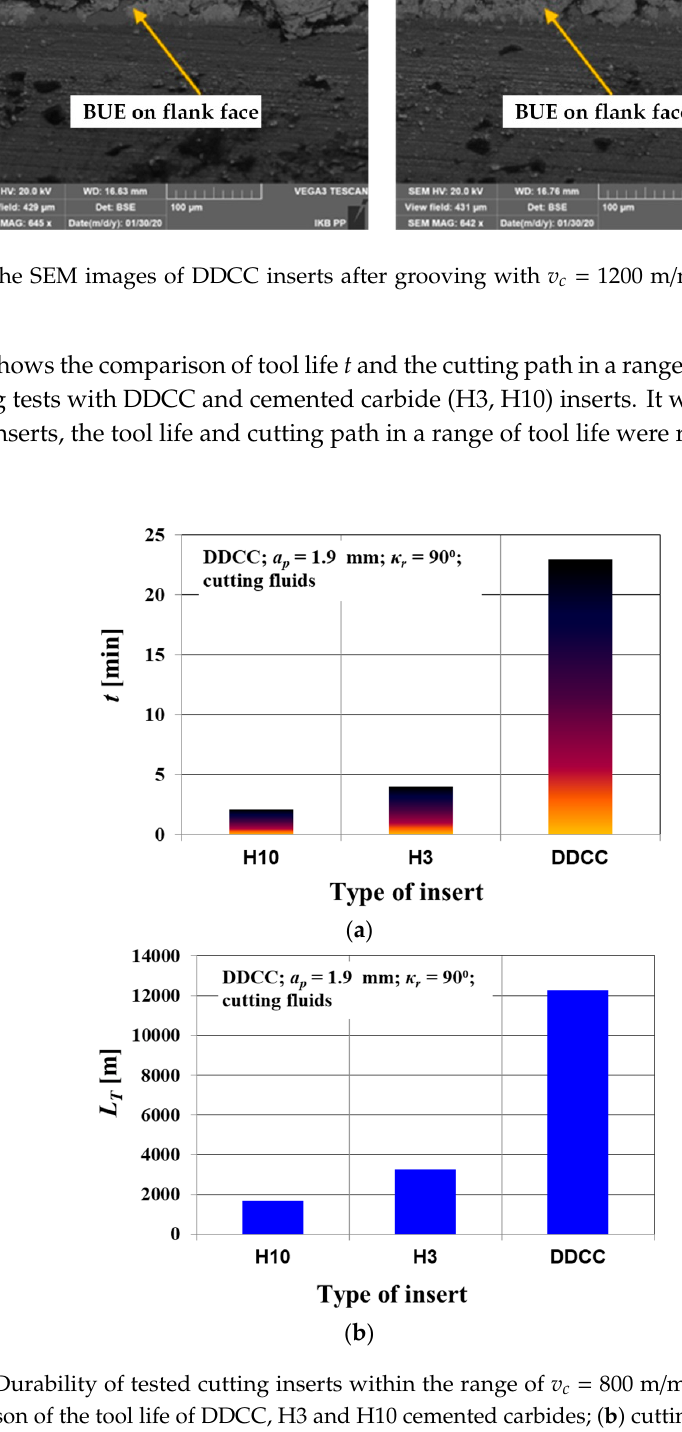
Figure 11. The comparison of tool life and cutting path over the tool life for DDCC inserts after grooving with various cutting parameters.